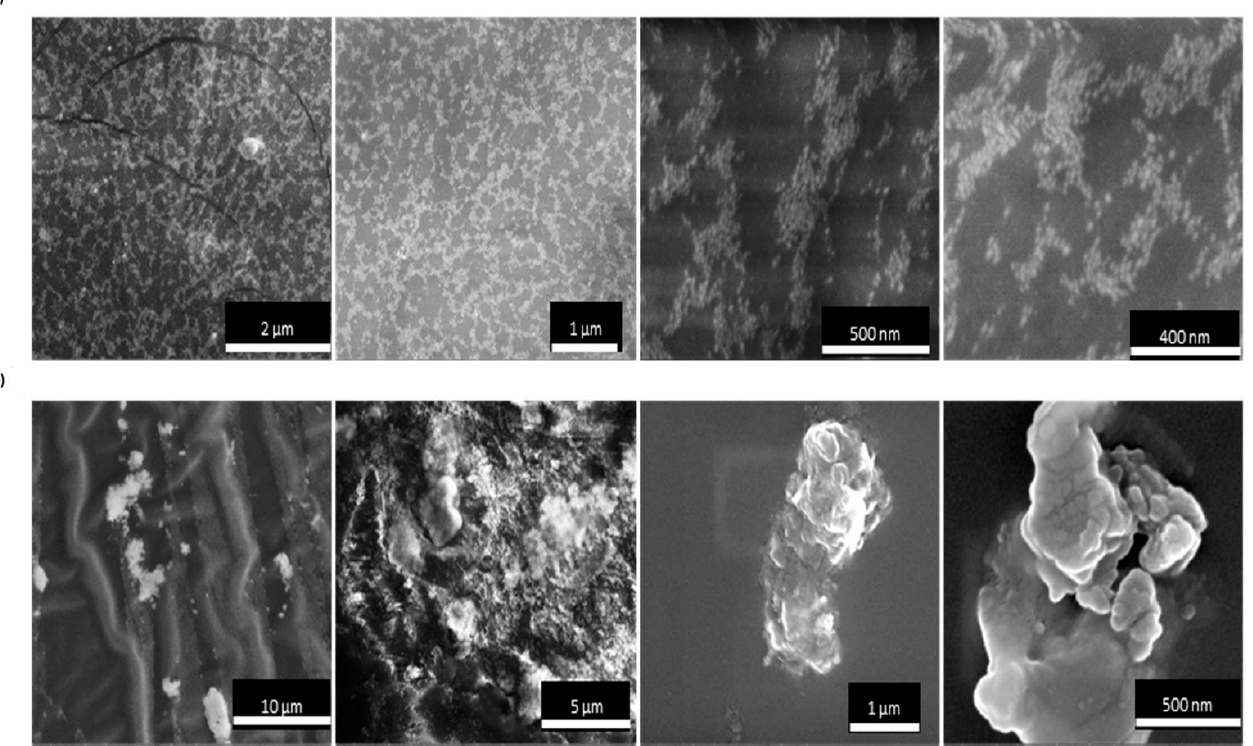
Figure 8. Cross-sectional SEM images, at different magnifications, of the GNPs-MPA doped gel at ( a ) pH 8.72 and ( b ) pH 2.16.